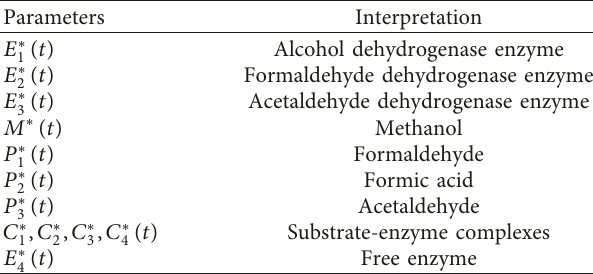
Table 1: Variables’